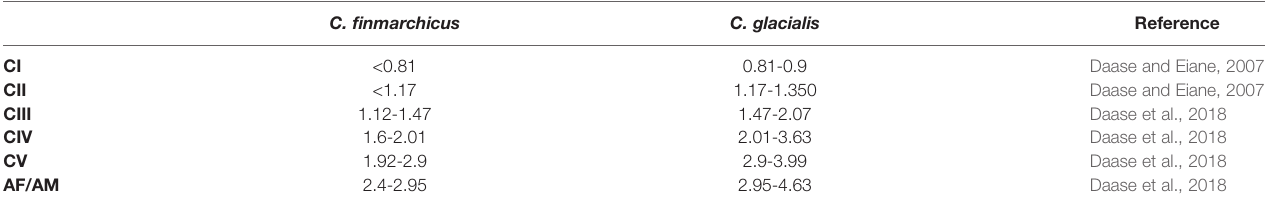
TABLE 1 | Size ranges (prosome length, mm) used to differentiate between copepodite stages CI-CV and adult females and males (AF/AM) of C. fi nmarchicus and C. glacialis based on Daase and Eiane (2007) with adjustments for CV and adults after Choquet et al. (2018) and Daase et al.